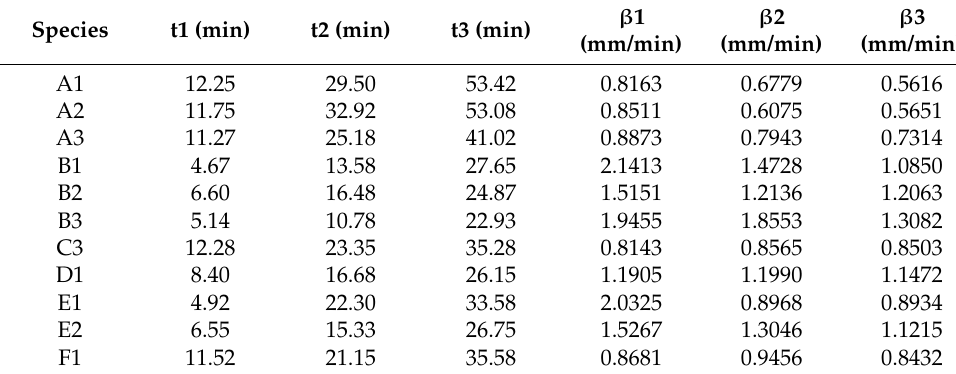
Table 4. Instantaneous charring rates of samples.